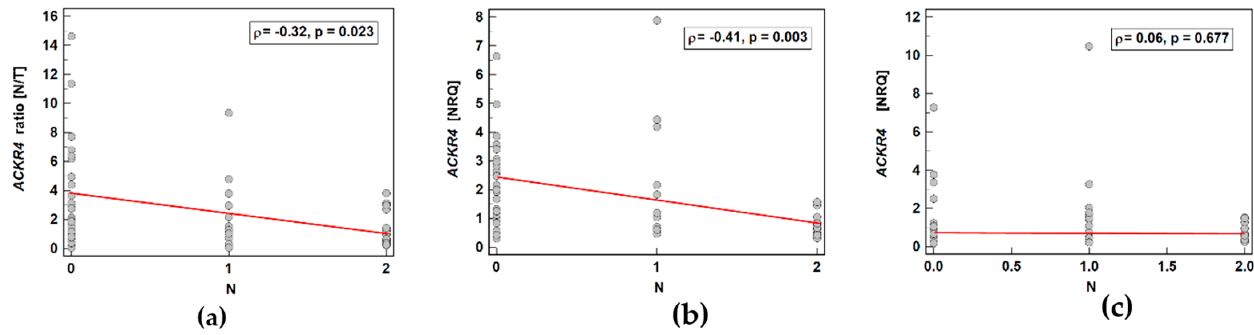
Figure 8. Correlation between cancer N stage and ACKR4 expression: ( a ) as a normal–to-tumor expression ratio (N/T); ( b ) in macroscopically normal tissue; ( c ) in tumors. Data presented as Spearman correlation coefficient rho ( ρ ) represented graphically as a red trend line. NRQ, normalized relative quantity.